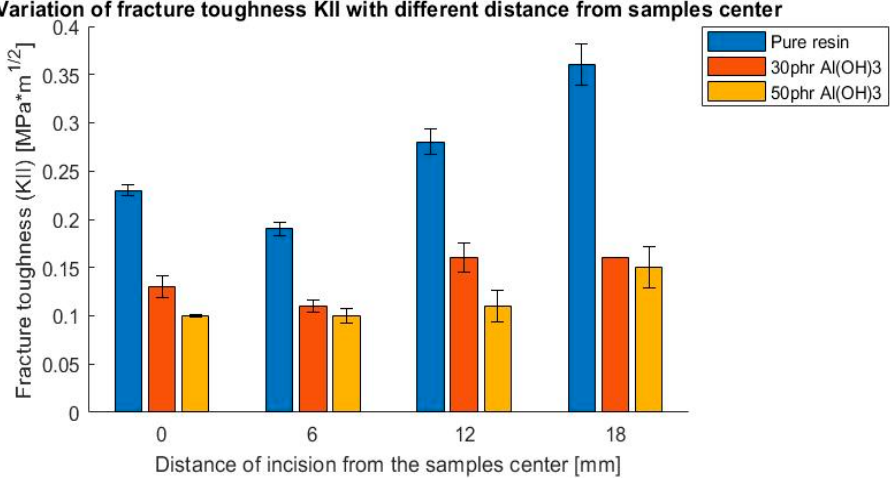
Figure 10. Variation of fracture toughness K II with different distances from the sample center, 3-point bending test.